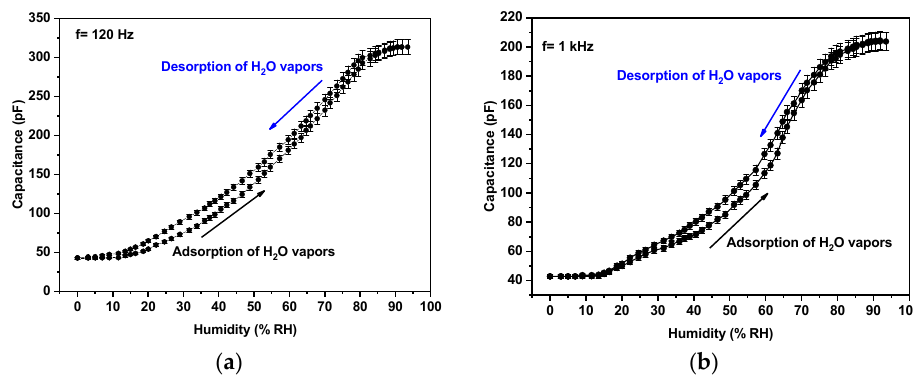
Figure 8. Hysteresis curves of Ag/PAD/Ag sensor at ( a ) 120 Hz and ( b ) 1 kHz.